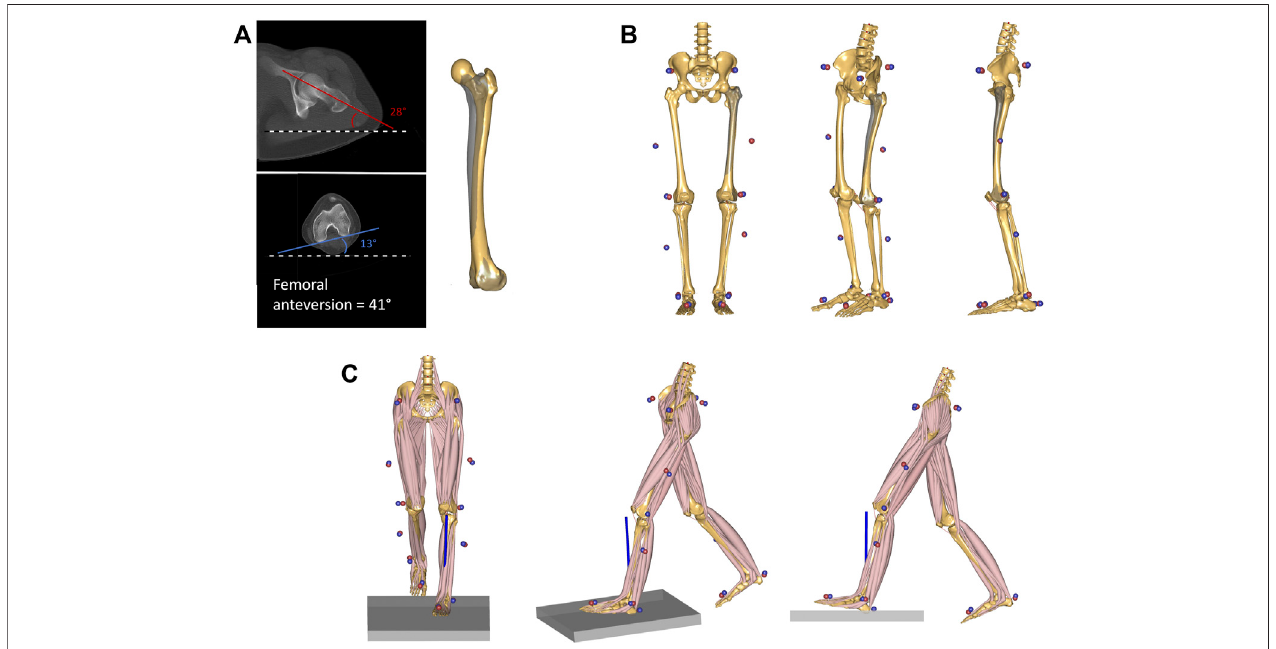
FIGURE 1 | (A) CT-measurement of femoral anteversion in one of the investigated patients. The angle between the horizontal reference (black and white dashed line) and both femoral neck axis (red) and the posterior contour of the femoral condyles (blue) were measured. The femoral anteversion angle is reported as a sum of the twovalues.Thefemoralgeometryofthemusculoskeletalmodelwasthenpersonalizedtomatchthemeasuredtorsionalvalue.Theoriginalunscaledfemoralgeometryis shown in shaded grey, while the personalized geometry is shown in solid yellow. (B) The model was scaled to match the subject ’ s anthropometrics based on marker data collected during a standing reference trial. The measured markers ’ data are presented as blue spheres, while the virtual markers attached to the musculoskeletalmodelareshownasredspheres. (C) Kinematicandkineticanalysesduringgaitwerebasedonthetrackingofthemeasuredmarkertrajectoriesandthe ground reaction forces. An inverse dynamics analysis based on a third-order-polynomial muscle recruitment criterion was performed to calculate required muscle activations, as well as resulting joint moments and contact